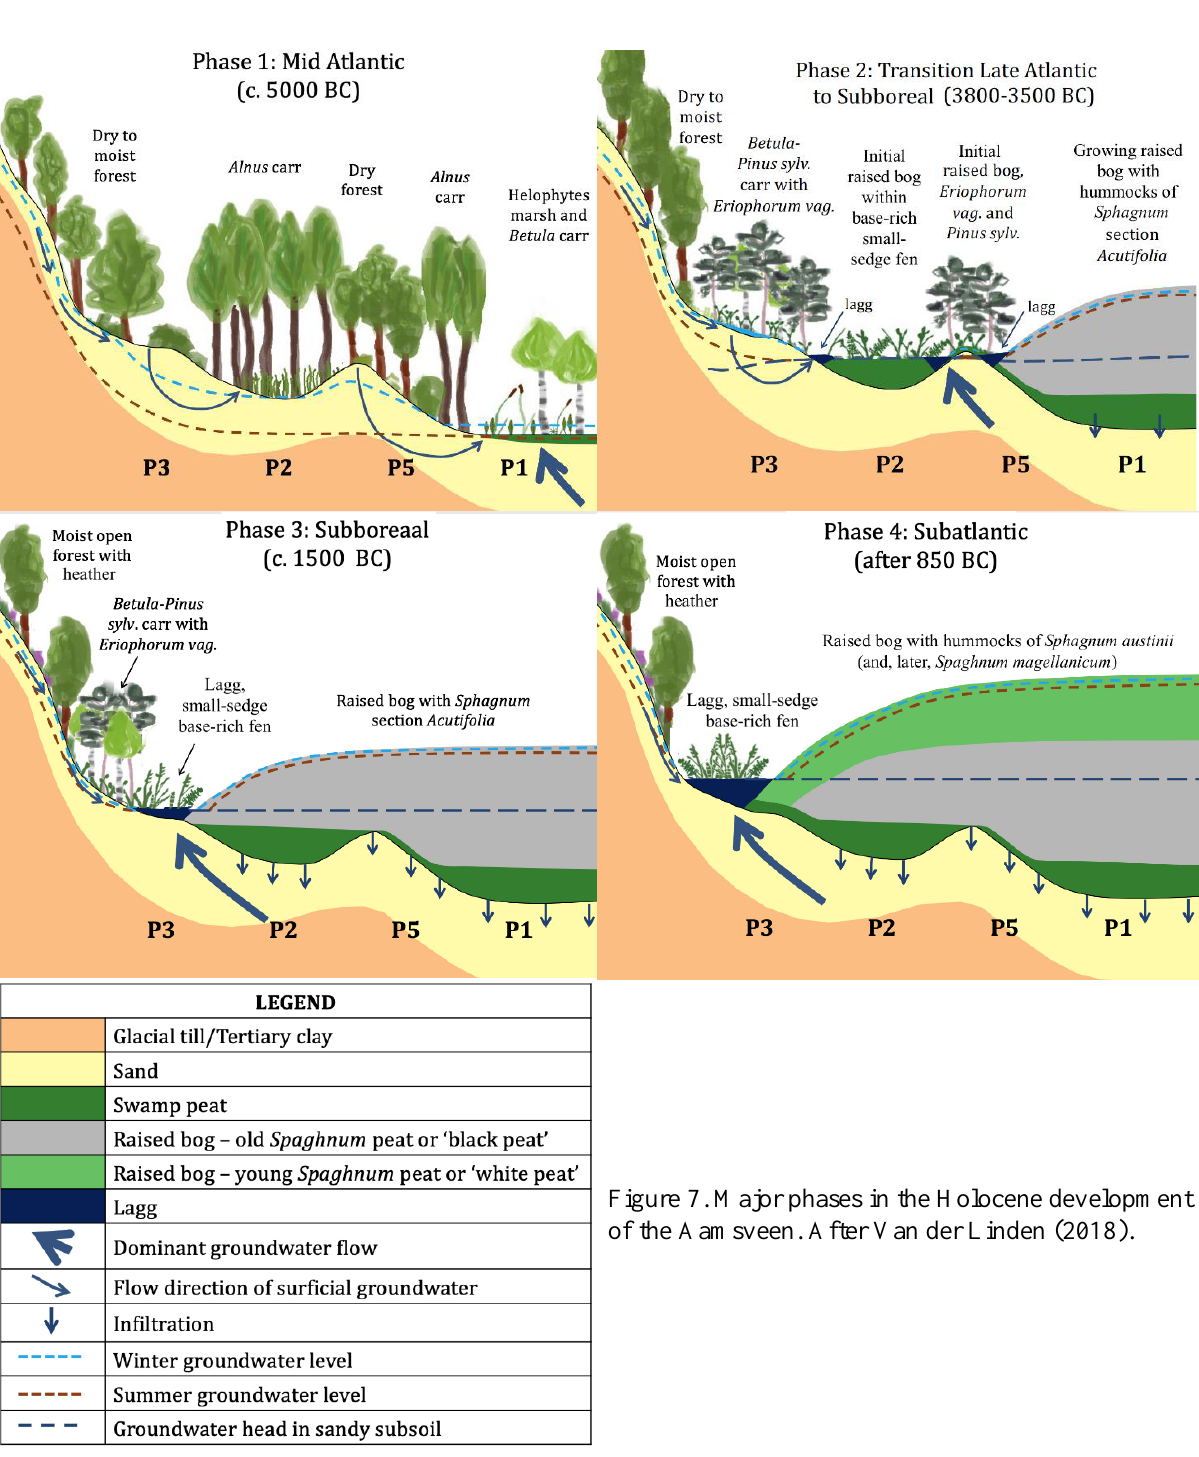
Figure 7. Major phases in the Holocene development of the Aamsveen. After Van der Linden